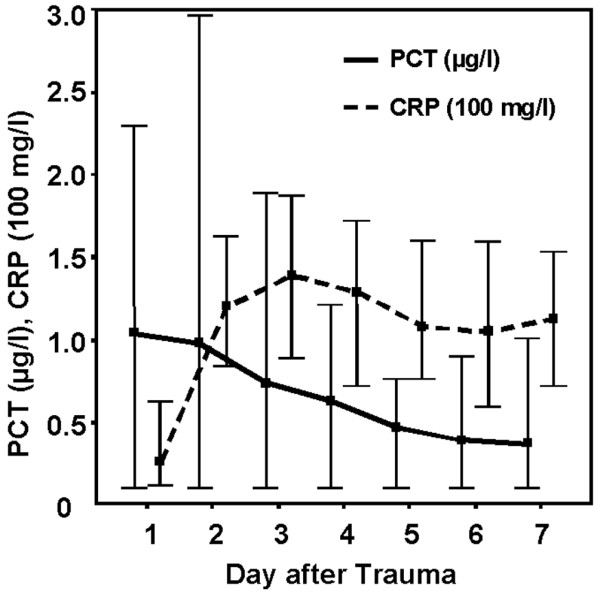
Serum levels of procalcitonin (PCT) and C-reactive protein (CRP) in patients with multiple trauma. Time course of induction (median, quartiles).